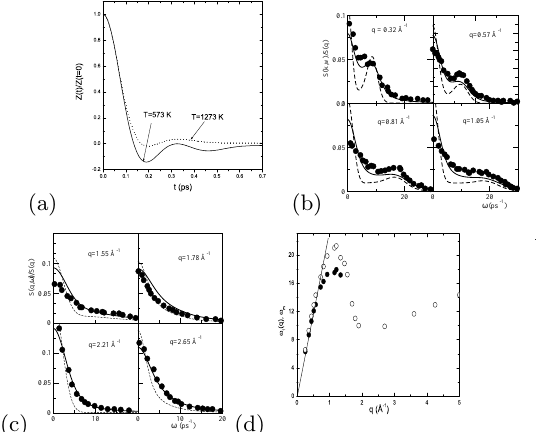
Fig. 2. (a) Velocity autocorrelation function. (b-c) Dy- namic structure factors S(q, ω ) compared with the exper- imental data at T= 573 K.Full circles for experimental data, dashed and solid line OFAIMD results before and after convolution, respectively, with experimental resolu- tion function. (d) Dispersion relation, closed circles ob- tained from the side peak frequency and open circles from the peak positions of the longitudinal current correlation